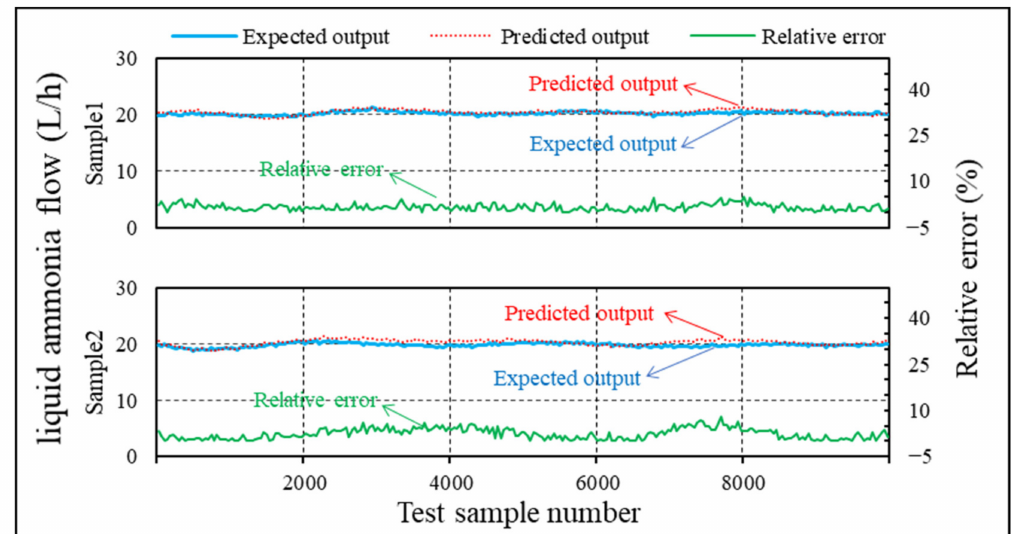
Figure 10. Predicted liquid ammonia flow by ELM.